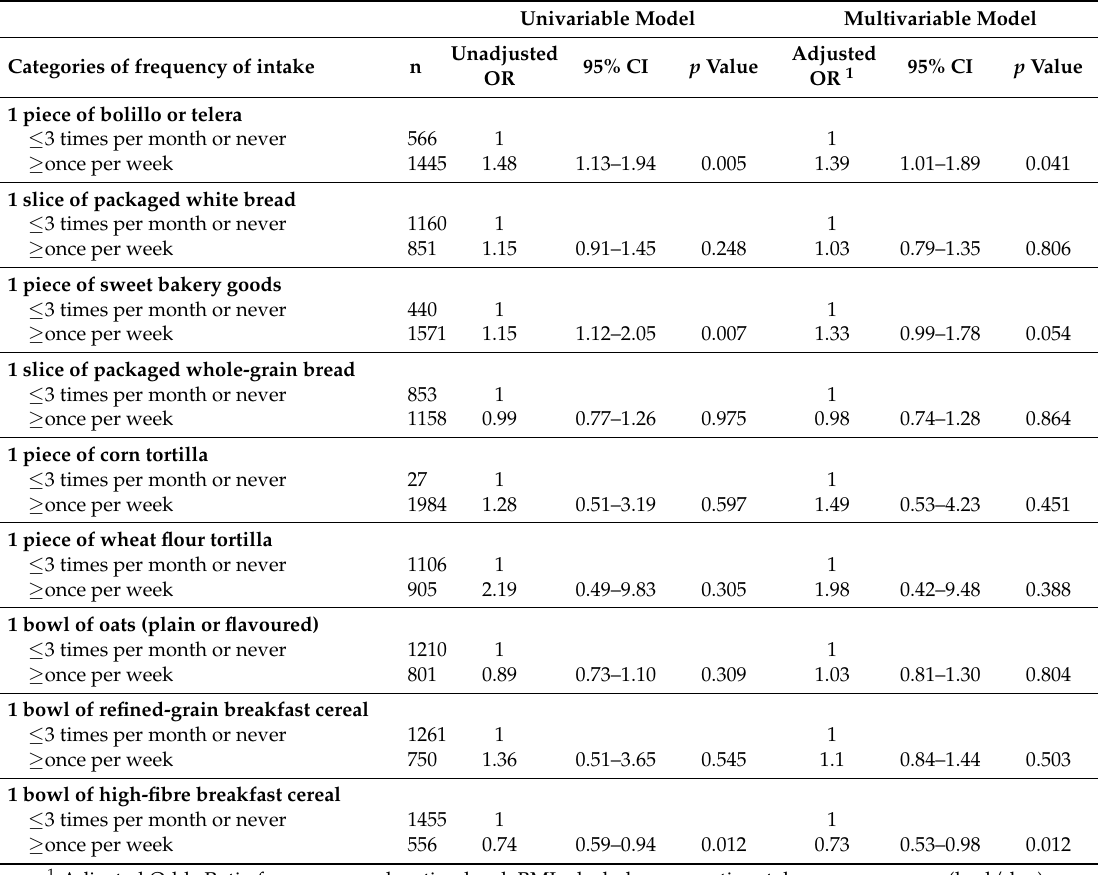
Table 4. Logistic regression analysis for the association between consumption of bread and other cereal-derived products at least once per week and elevated blood pressure